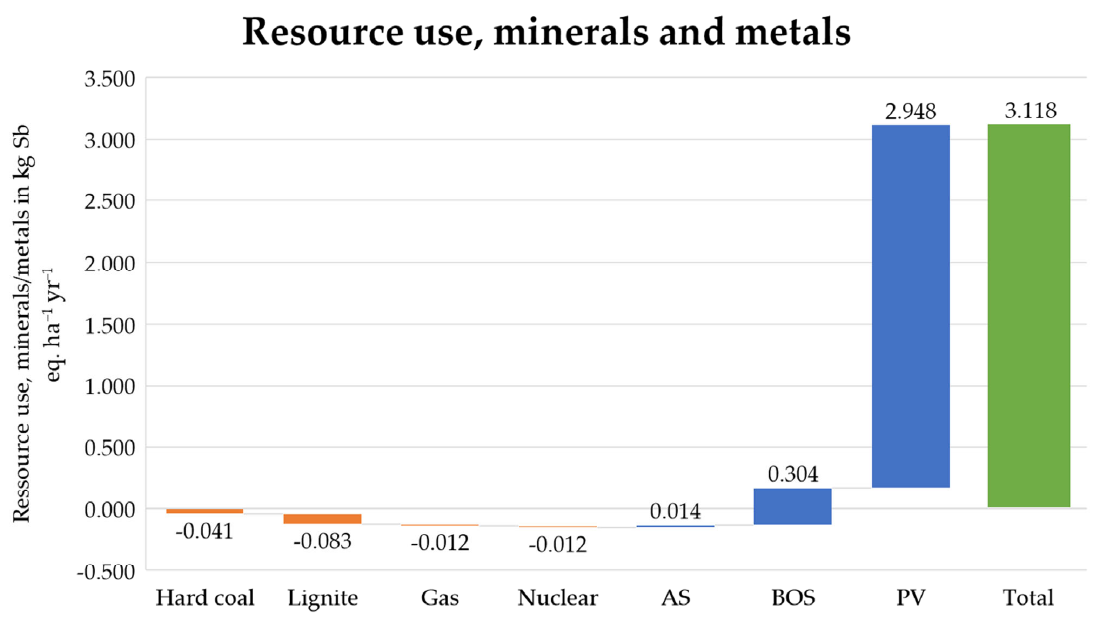
Figure 6. Environmental impact of the change of 1 ha single ‐ use agriculture to an overhead AVS in Germany in the category resource use, minerals and metals per year (AS: agricultural system, BOS: balance of system, PV: PV modules).